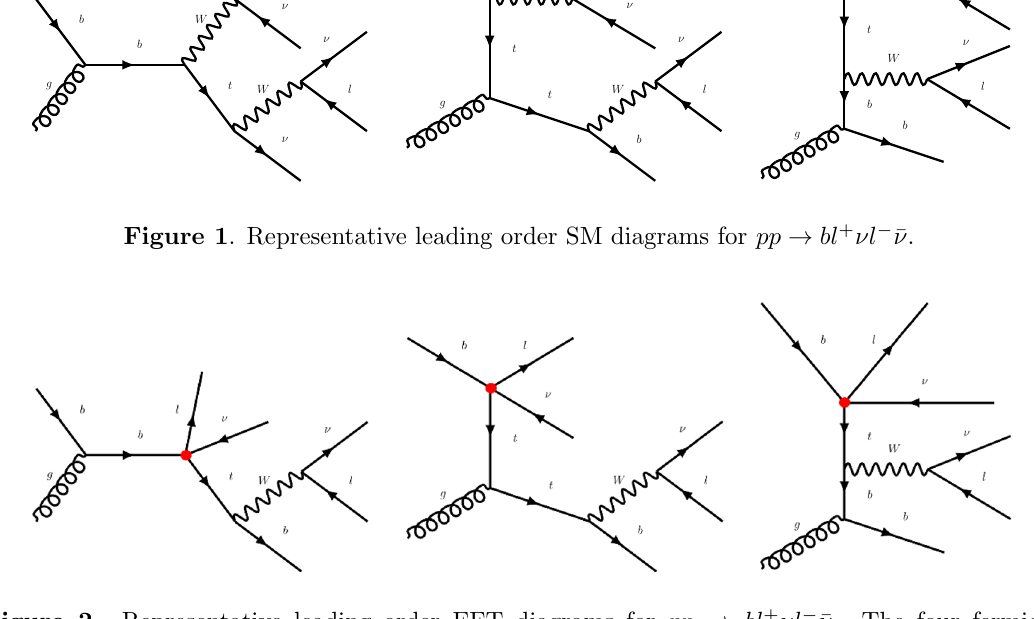
Figure 2 . Representative leading order EFT diagrams for pp interactions are shown with a red dot.